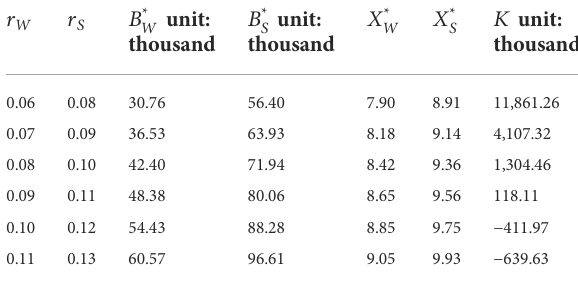
TABLE 2The in fl uence oftherisk discountedrate r i , i (cid:2) W , S on B * W , B * S , X